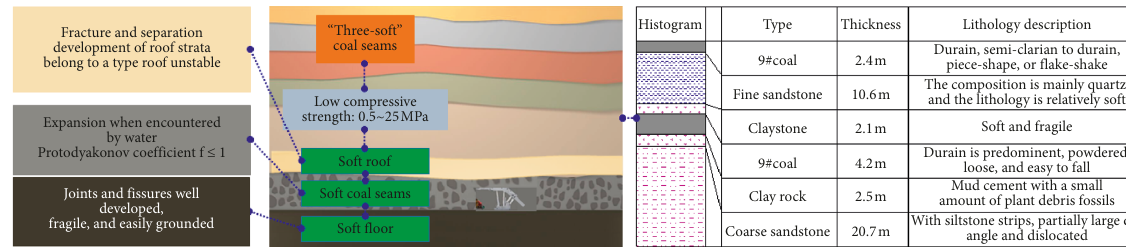
Figure 2: Characteristics of the “three-soft” coal